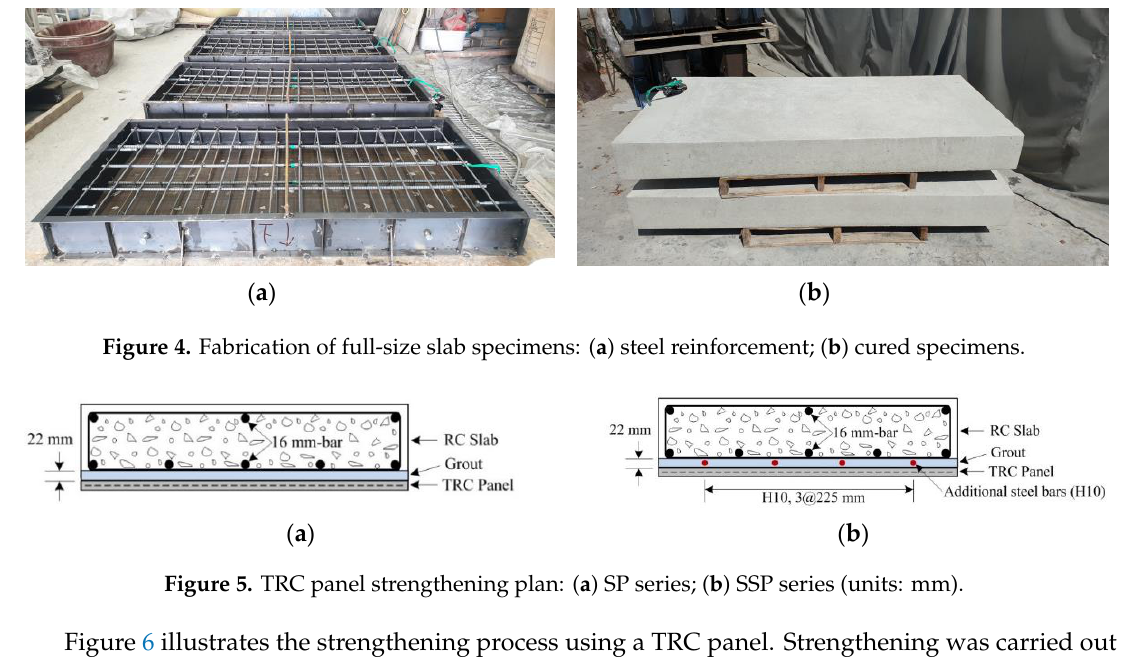
Figure 3. RC slab: ( a ) cross-sectional view; ( b ) reinforcement details (units: mm).